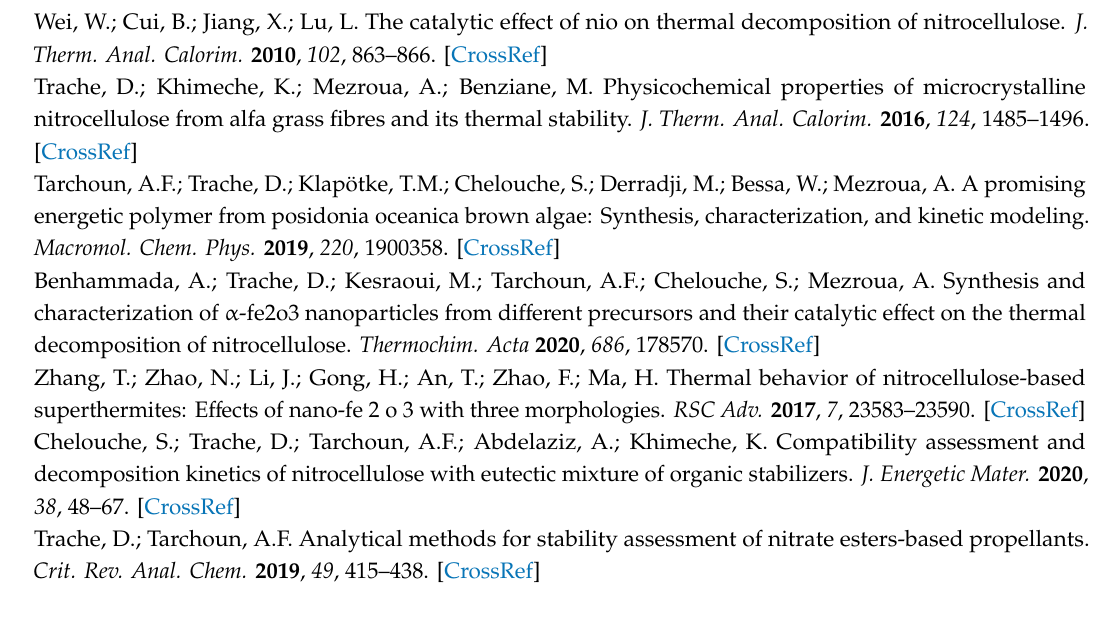
Figure S1: SEM images treated with ImageJ (a, b) CMS, (c, d) CMS-Fe 2 O 3 ; Figure S2: Particle size distribution using ImageJ software for MCS; Figure S3: Particle size distribution using ImageJ software for Fe 2 O 3 -MCS; Table S1: Statistics on columns of particle size distribution for MCS; Table S2: Statistics on columns of particle size distribution for Fe 2 O 3